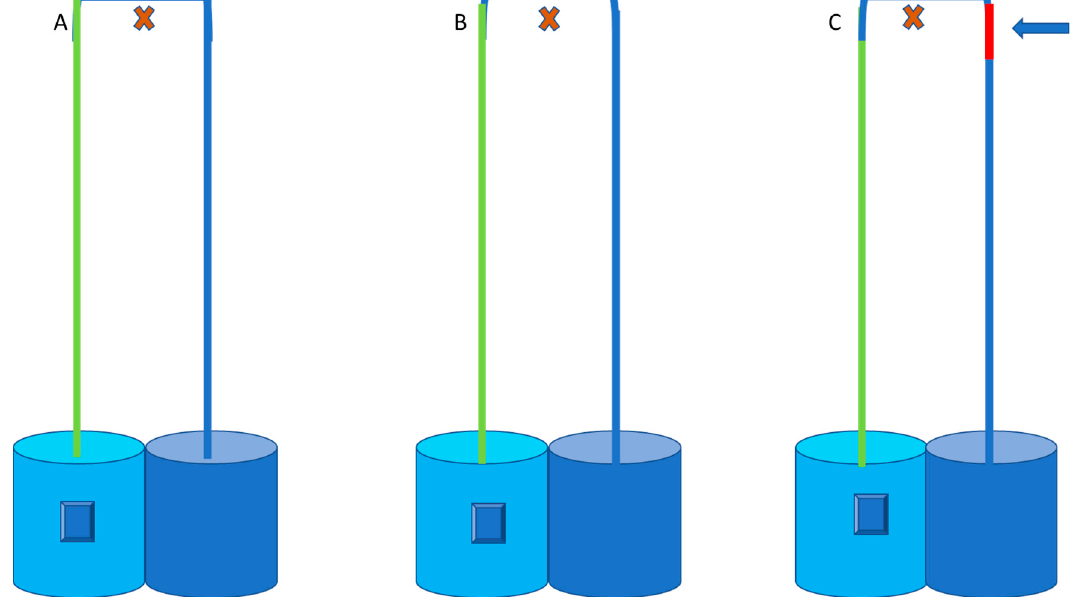
Figure 3. Schematic presentation of the three variations with non-collapsible ( A ), collapsible ( B ) and collapsible tubing with cranial siphon add-in ( C ) as indicated by the blue arrow and the red cross indicating the brain